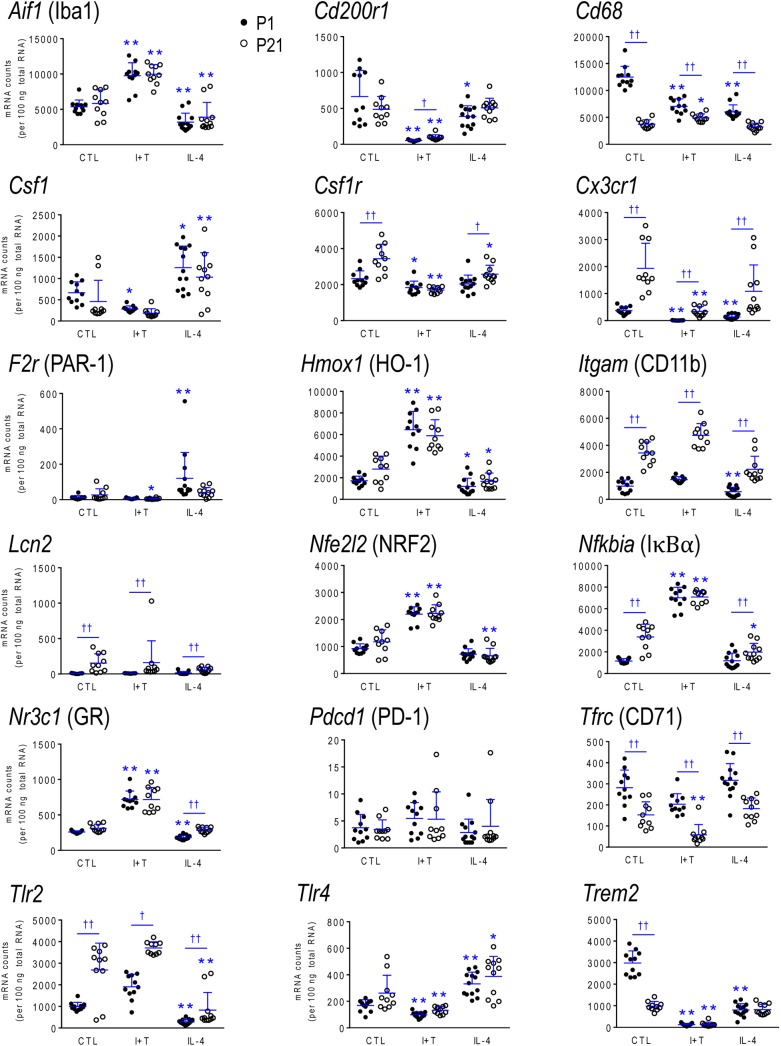
Age-dependent transcriptional responses: Microglia markers and modulators. As in Figure 2, microglia were stimulated for 24 h with IFNγ and TNFα (I+T) or IL-4. The scatterplots show individual mRNA values (normalized; see Materials and Methods) and the mean ± SD. Differences shown are with respect to control microglia (∗) and between P1 and P21 cells (†). One symbol of either type indicates p < 0.05; two symbols, p < 0.01.